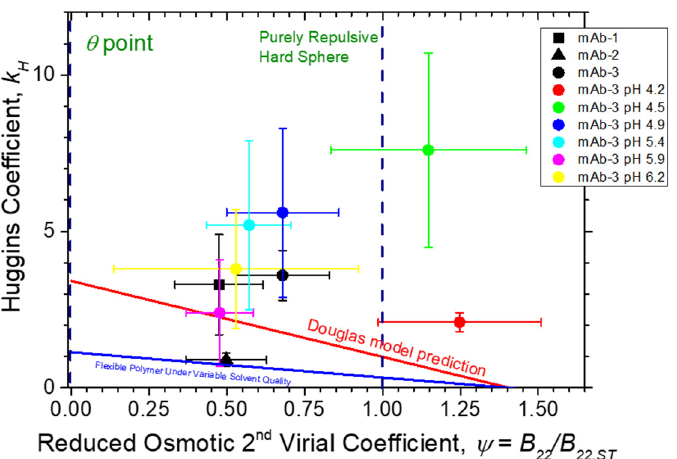
Figure 5. Huggins coefficient k H vs. reduced osmotic second virial coefficient. Comparison of Ψ (circles) to Douglas et al. [23] model prediction (continuous red line; Equation (4)) and an estimate (see text for discussion) for flexible polymer chains with variable excluded volume interaction (continuous blue line). Uncertainty estimates were determined from the non-linear regression of Equation (2) to η data, and linear regression of Equation (6) to SLS Kc 2 / R θ data. Dashed vertical lines denote limiting k H values at the θ point ( Ψ = 0) and for purely repulsive hard spheres ( Ψ ≈ 0.99), respectively.